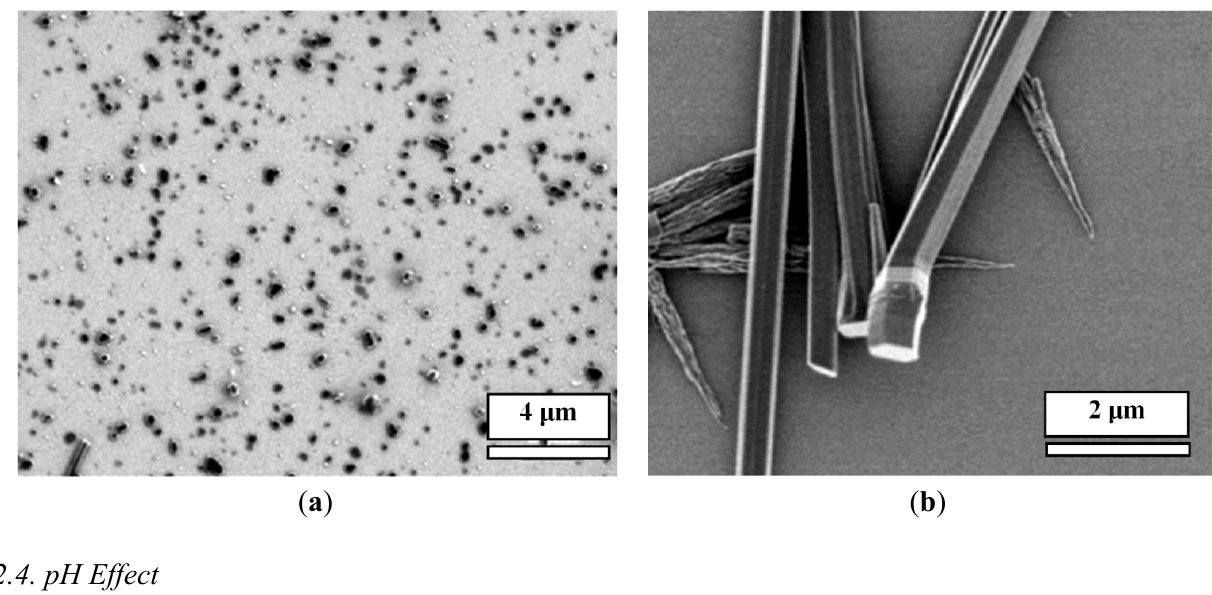
Figure 6. SEM images of: ( a ) CA/M nanoplate on gold surface fabricated from mixing CA and M at 1 × 10 − 5 M on a gold surface; and ( b ) CA/M crystal microwires and the irregular structures on the gold surface fabricated from mixing CA and M at 0.01 M on a gold